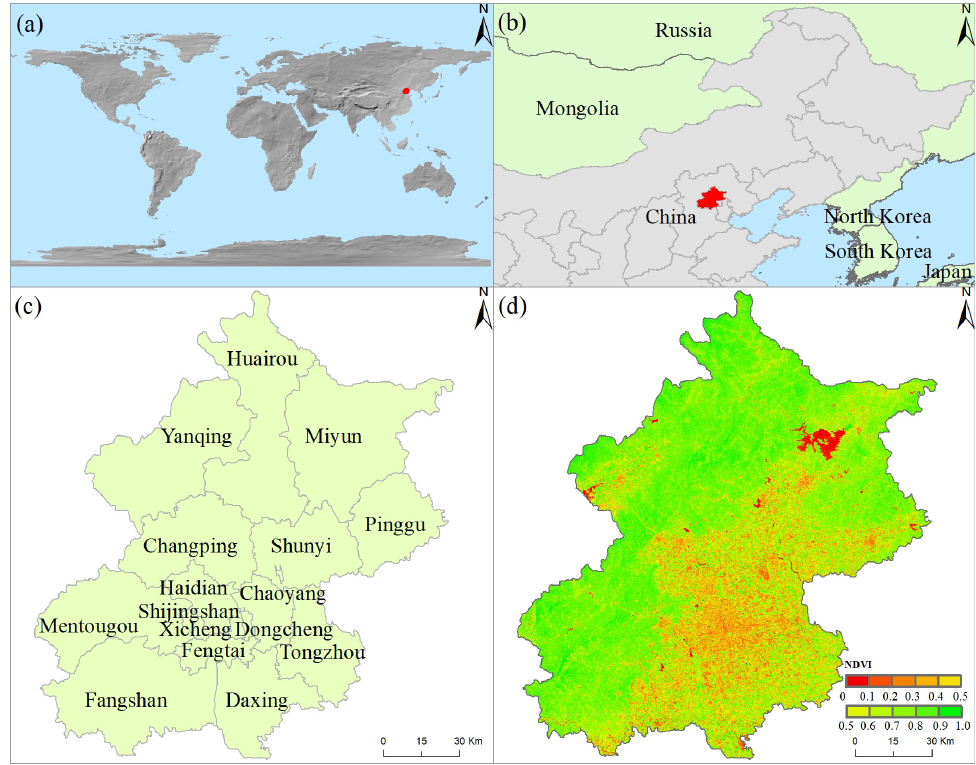
Figure 1. Spatial map of the geographic study area. ( a ) Location of the Beijing (red colour) worldwide, ( b ) Location of the Beijing (red colour) in Northern China, ( c ) Administrative division of the Beijing, and ( d ) Vegetation covers synthesized according to the maximum of normalized difference vegetation index from time series of environmental images in the year of 2021.